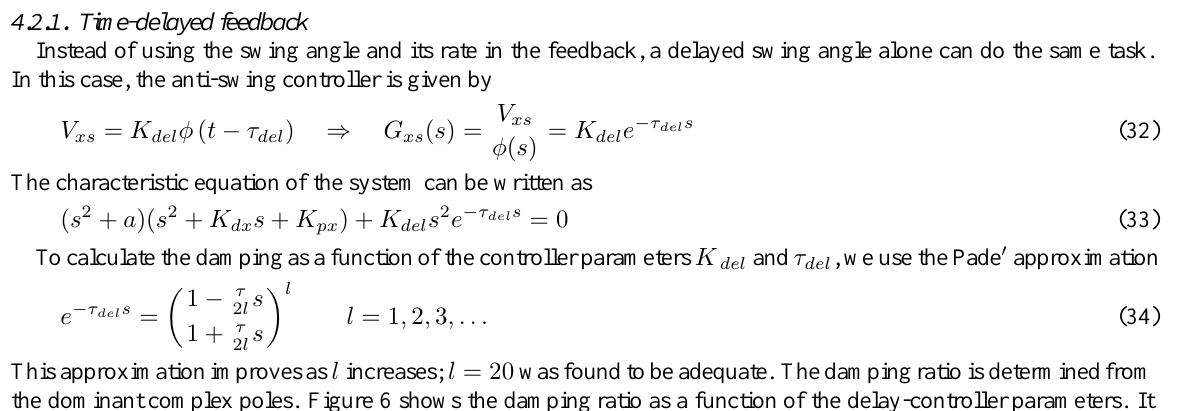
Fig. 6. The damping map of the first delay